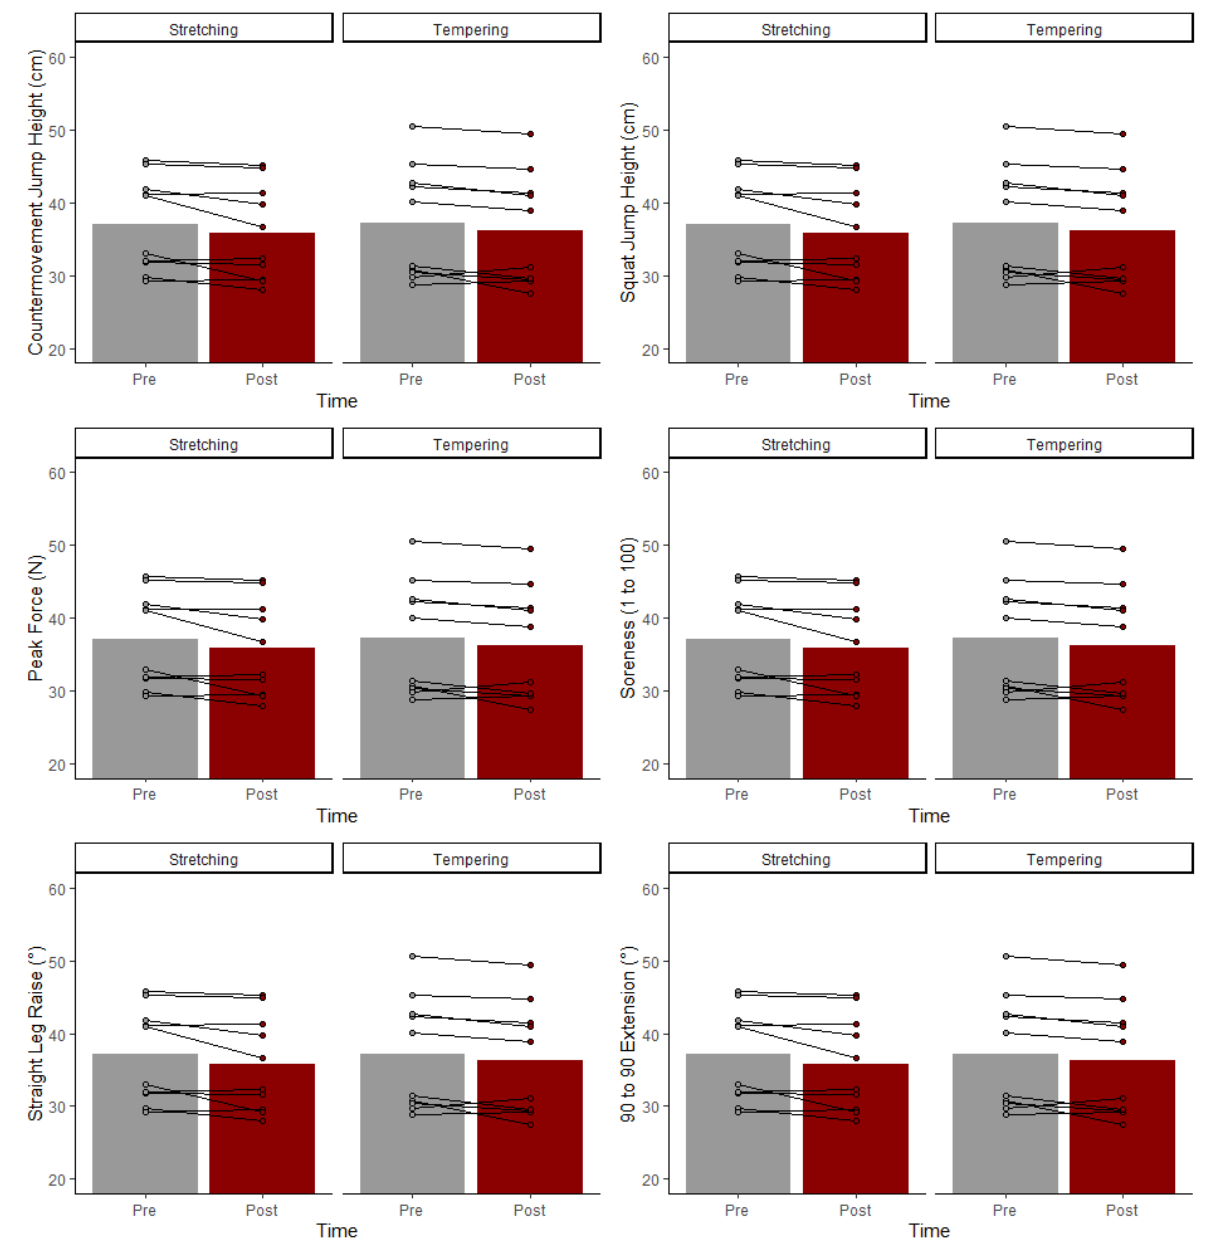
Figure 1. Group and individual responses for select testing metrics for stretching and body tempering.